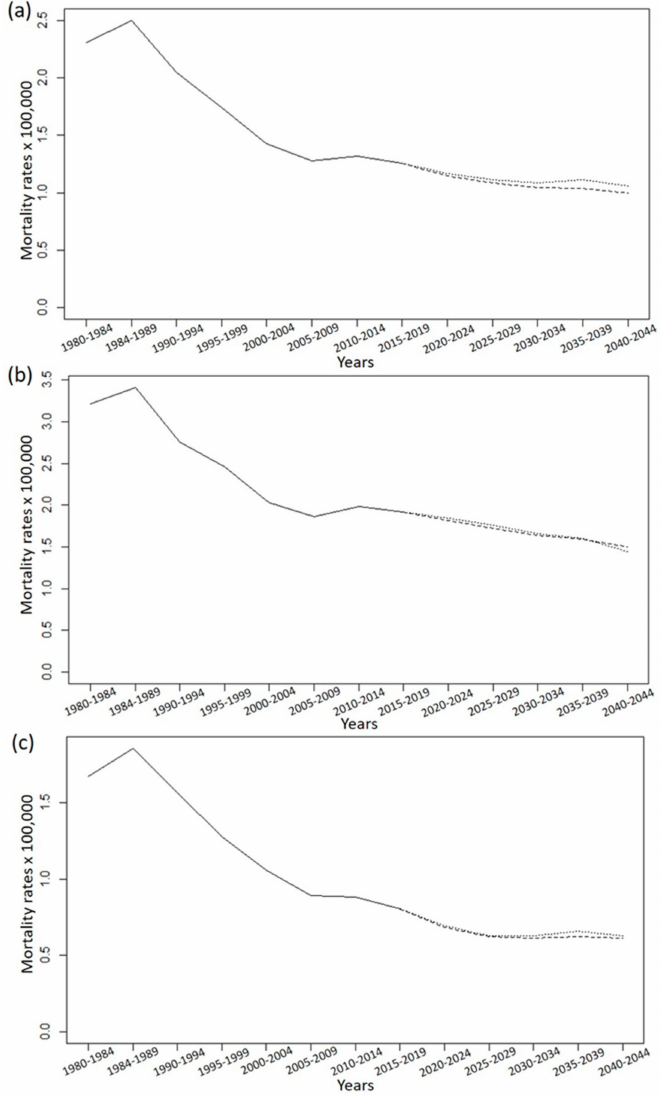
Figure 2. Observed (1980–2019) and predicted (2020–2044) overall mortality rates for NMSC in Spain. ( a ) Both sexes; ( b ) males; ( c ) females. Dashed line: Prediction Power5. Dotted line: